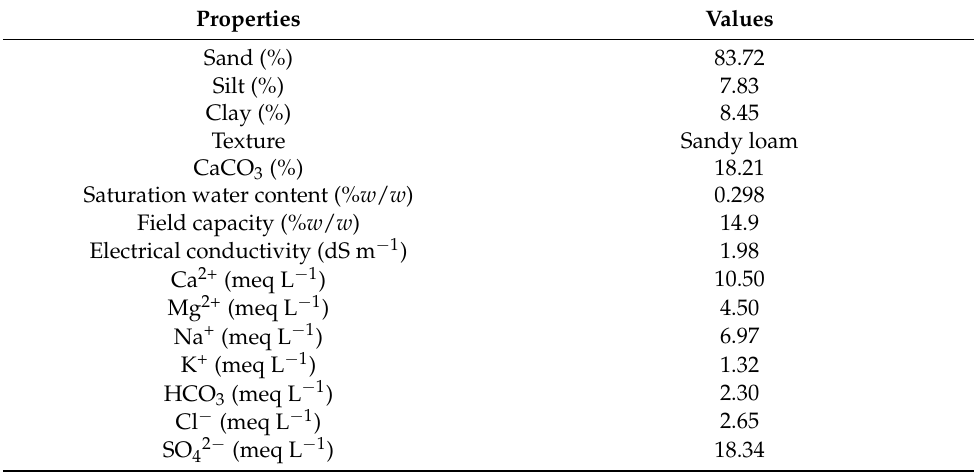
Table 1. Physical and chemical characteristics of the